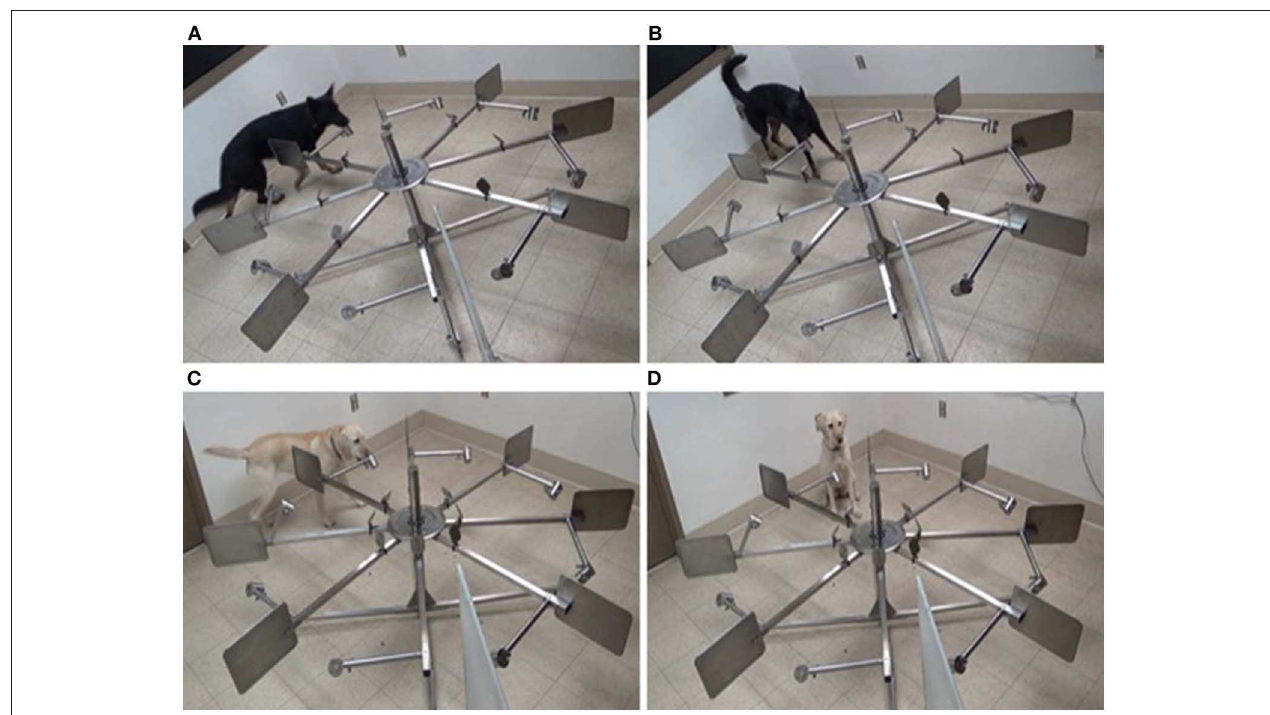
computer monitor screen via video. Dogs are trained on an eight- armed wheel with a “port” on each arm (Medical Detection Dogs, DEMAND—Design and Manufacture for Disability). Each port denotes a receptacle for one sample (see Figure 1 ). Within each port there is either (1) blood plasma taken from an individual with confirmed ovarian cancer, (2) blood plasma taken from an individual with a benign ovarian tumor (herein denoted as “benign”, (3) blood plasma taken from a healthy individual (herein described as “normal”), (4) a control (a non-biological substance that is involved in the study process and may interfere with the identification of the target odor, e.g., latex gloves, as these are worn when handling samples), or (5) a distractor (a non-biological, unrelated, object e.g., paper clips). Dogs were presented with 75 µ l of blood plasma during imprinting, and 50 µ l in all subsequent training. For each “hot” trial, there is one cancer sample present (the target odor), and up to two benign or normal samples, the remaining ports contain distractors or controls. For one dog (McBaine, sit alert), an older version of the wheel that has twelve ports was being used at the time of recording (Anne B Kingsley Wheel). The distribution of and quantity of biological samples was identical, with the additional ports being used for additional distractor objects. For all dogs, each session contained ten trials, with 30-50% of these trials being “blanks” (no cancer sample is present). In blank trials, dogs are expected to check all ports of the wheel, and then walk to a raised platform to signal that there is no target odor present. During blank trials, normal, benign, control and distractor samples are present in the